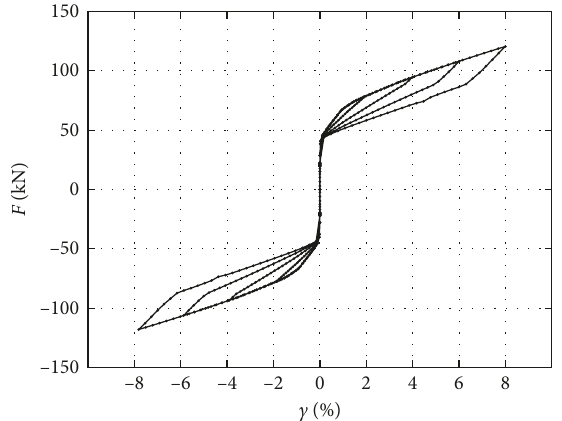
Figure 19: Shear force to link rotation response.